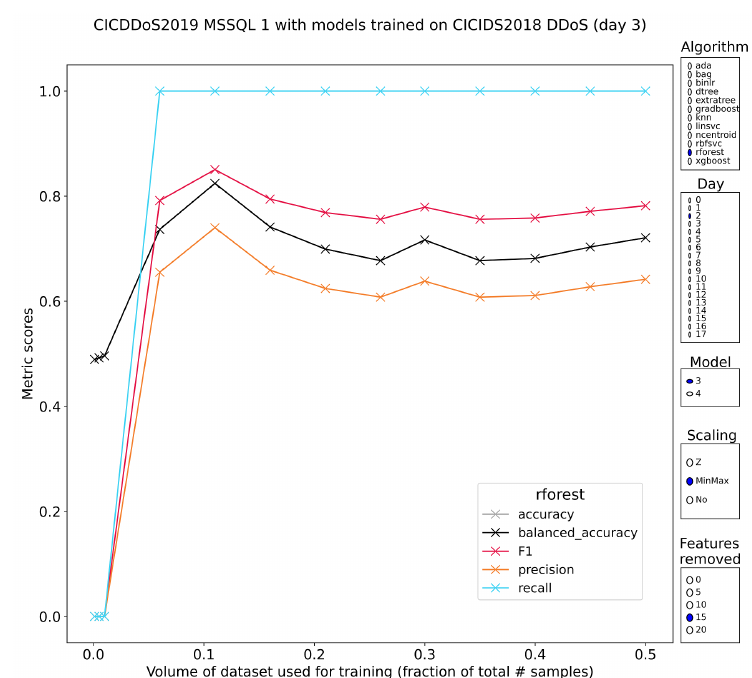
Figure 12. More observations of stable, general performance on the DDoS class by tree-based meta-